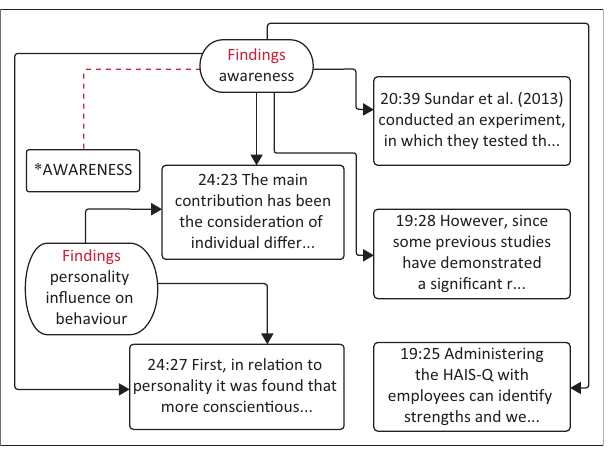
FIGURE 1: Example of co-occurrence in